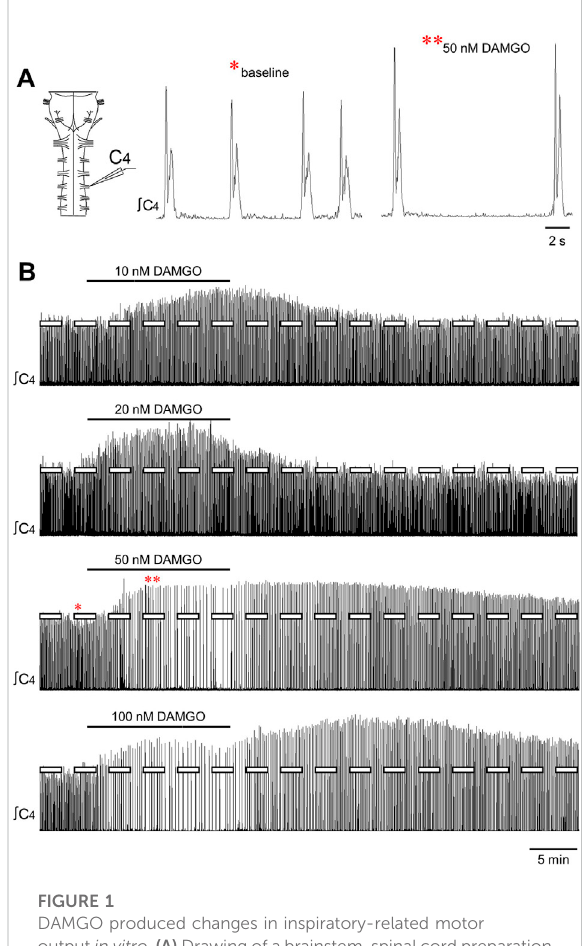
DAMGO produced changes in inspiratory-related motor output in vitro . (A) Drawing of a brainstem-spinal cord preparation with suction electrode attached at ventral cervical spinal root C4. At right is a sample voltage trace showing inspiratory-related motor bursts. (B) Effects of bath-applied DAMGO on inspiratory- related motor output are shown. DAMGO typically increased burst amplitude and decreased burst